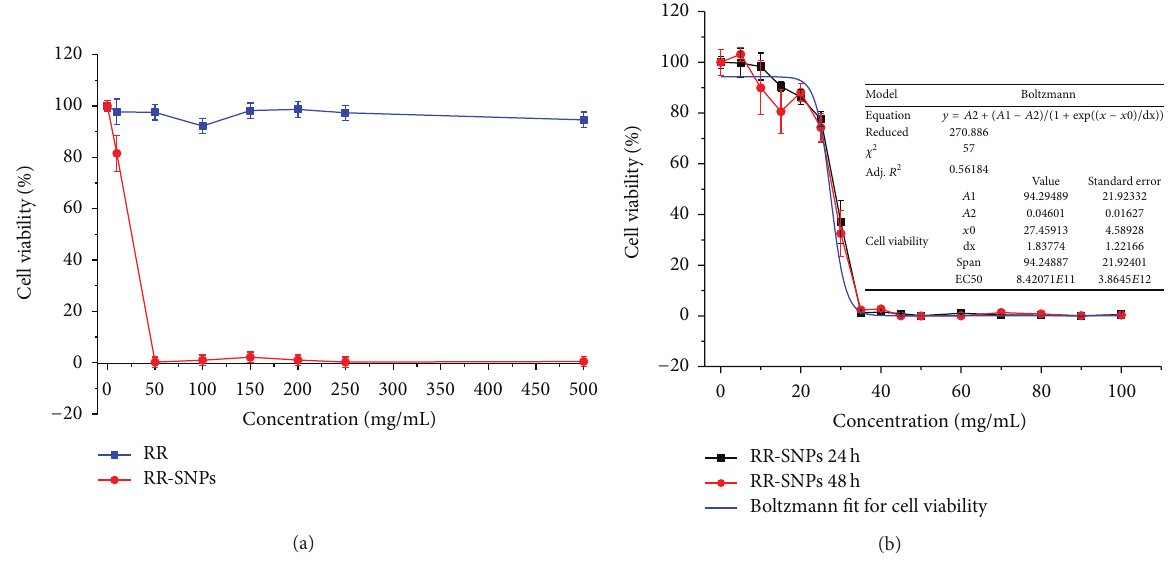
Figure 6: Anticancer activity of (a) RR and RR-SNPs on HeLa cell lines after 24 h of incubation and (b) RR-SNPs on HeLa cell lines after 24 h and 48h of